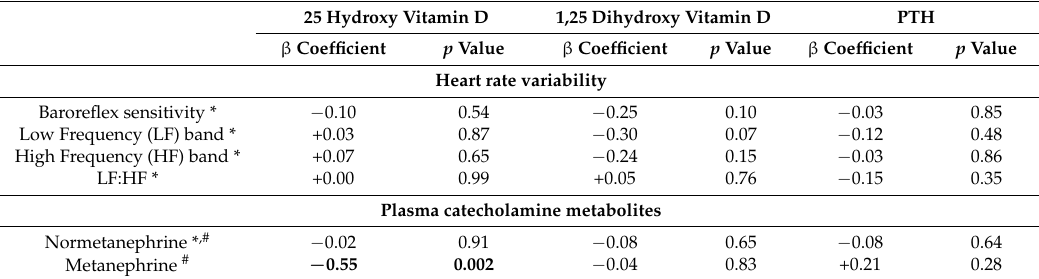
Figure 1. Simple linear regression relationship between serum 25 hydroxy vitamin D and plasma metanephrine in 43 subjects. Table 2. Multiple regression analyses of the relationship between vitamin D/parathyroid hormone (PTH) and measures of autonomic nervous system activity in 47 subjects.